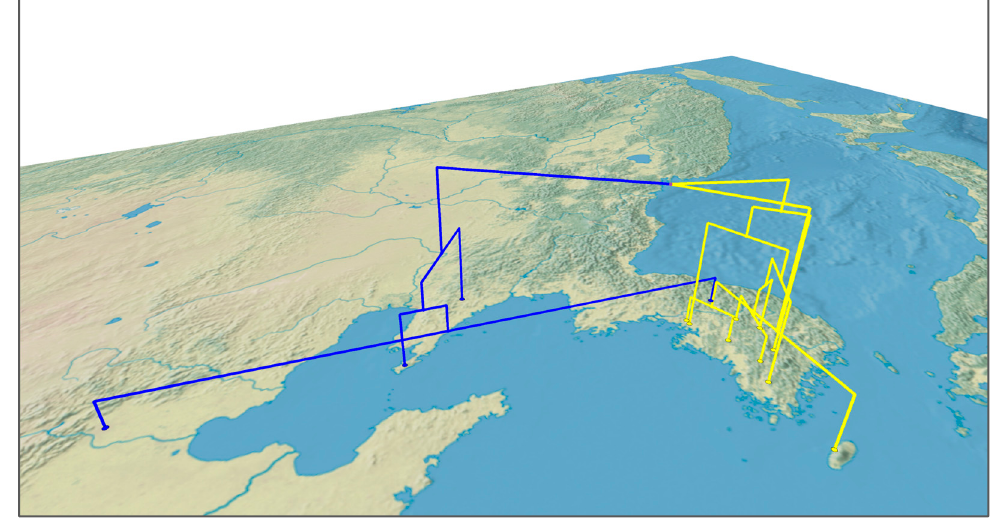
Figure 4. Neighbour-joining tree for Quercus acutissima Carruth. continental populations only, based on ( δμ ) 2 genetic distance.